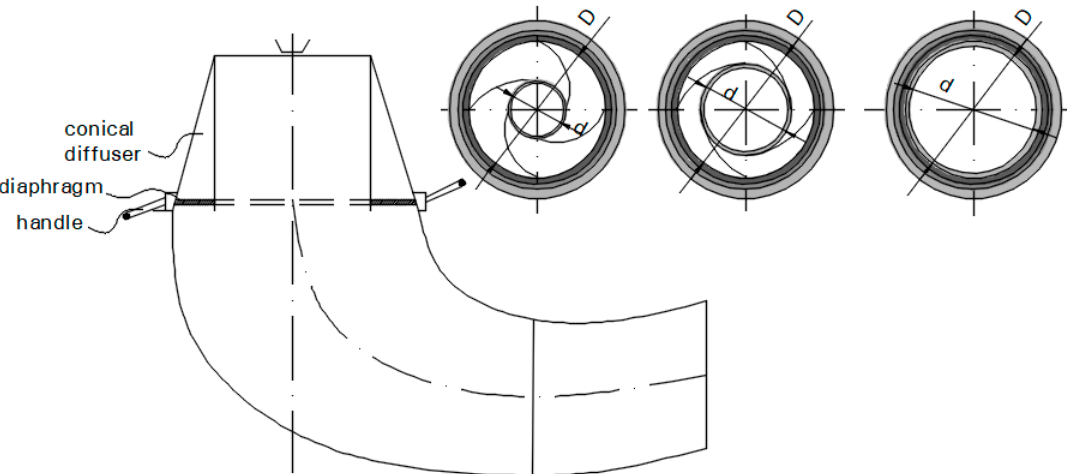
Figure 1. Meridian view of the elbow draft tube (cone, elbow and part of the diffuser) together with the adjustable diaphragm at the cone outlet. Three openings of the adjustable diaphragm associated to different operating points are detailed.